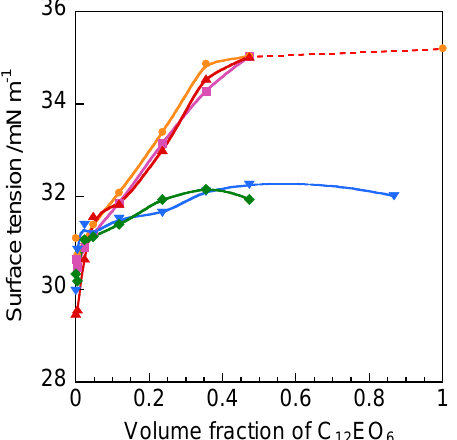
Figure 2. Surface tension as a function of the volume fraction of C 12 EO 6 in amphiphilic gemini ionic liquids at 25 °C: 2C 10 (2-O-2) NTf 2 (orange ●), 2C 12 (2-O-2) NTf 2 (pink ■ ), 2C 14 (2-O-2) NTf 2 (40 °C, red ▲ ), 2C 12 (2-N-2) NTf 2 (blue ▼ ), and 2C 12 (2/2-N-2) NTf 2 (30 °C, green ◆ ).